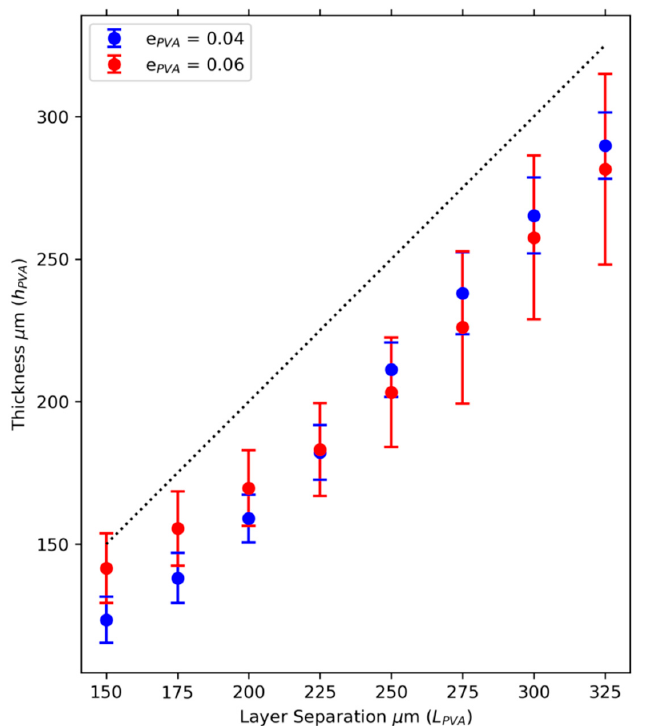
Figure 5. The variation in measured PVA thickness for layer separations ( L PVA ) between 150 and 325 µm. Gradients of 0.98 ± 0.03 and 0.80 ± 0.05 are shown for e PVA = 0.04 and 0.06, respectively. A trend of one-to-one variation in thickness with layer separation is represented by a black dotted line.